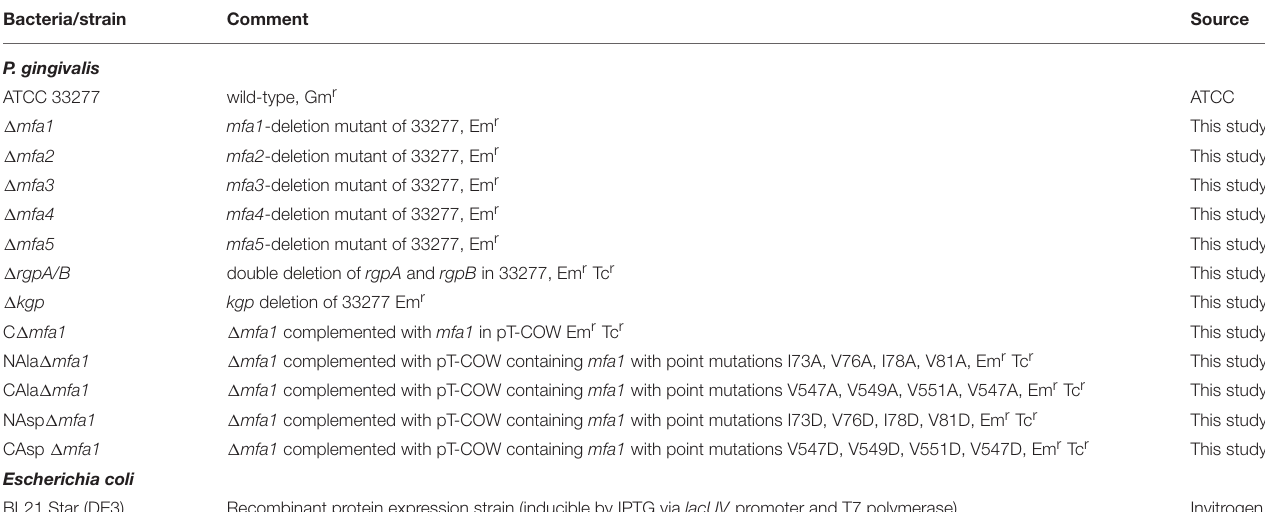
TABLE 1 | Bacterial strains used in this